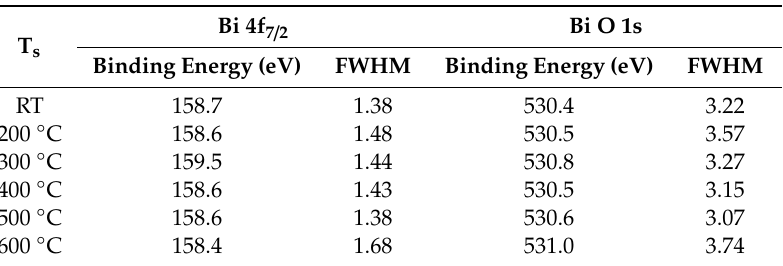
Figure 13. High ‐ resolution XPS spectra of ( a ) Bi 4f and ( b ) O 1s for Bi 2 O 3 :Ho 3+ thin films deposited at different substrate temperatures. Table 3. Peak positions and FWHM of the 4f Bi and O 1s XPS peaks of the Bi 2 O 3 :Ho 3 + thin films deposited at different substrate temperatures.